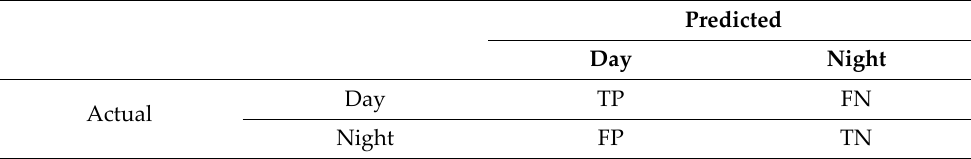
Table 1. Confusion matrix of clustering normal telemetry data evaluation measures.